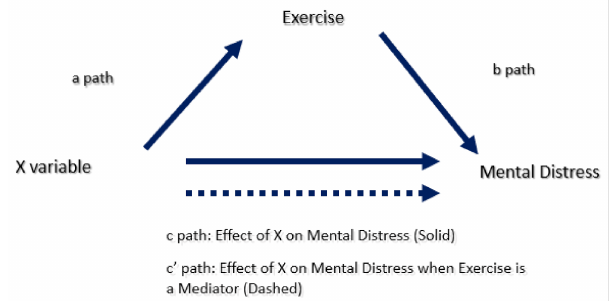
Figure 2. The mediation regression